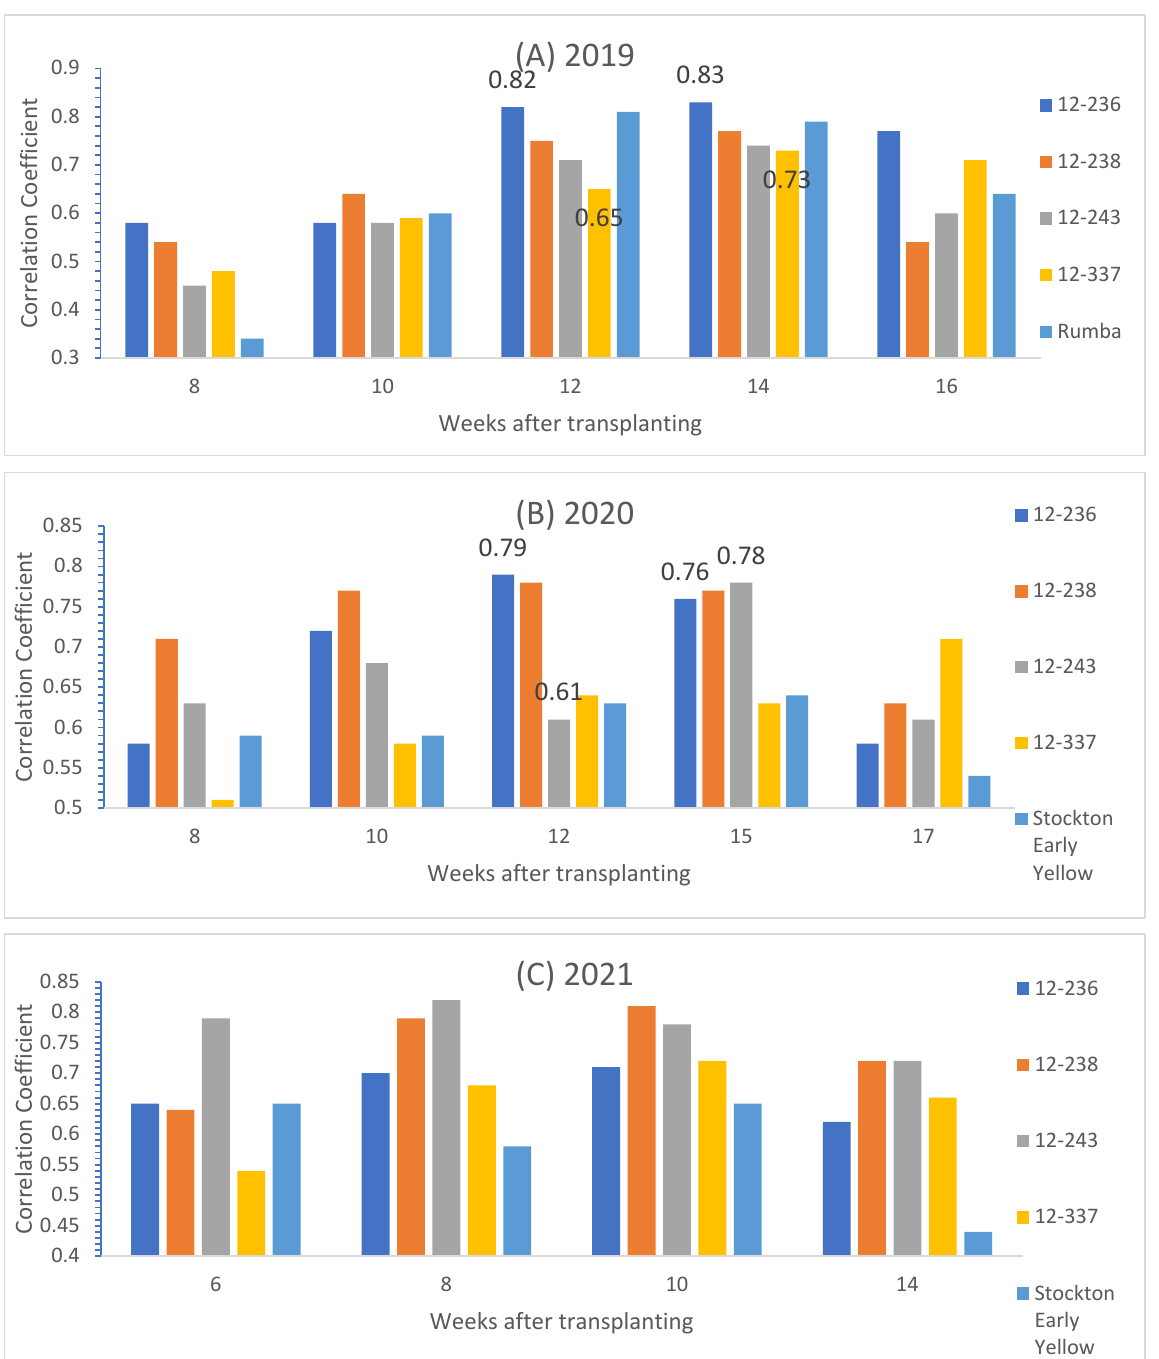
Figure 4. Correlations between sheath diameter and bulb weight through the growing season and for entries on per plant basis in ( A ) 2019, ( B ) 2020 and ( C ) 2021, at p < 0.001 significance level.